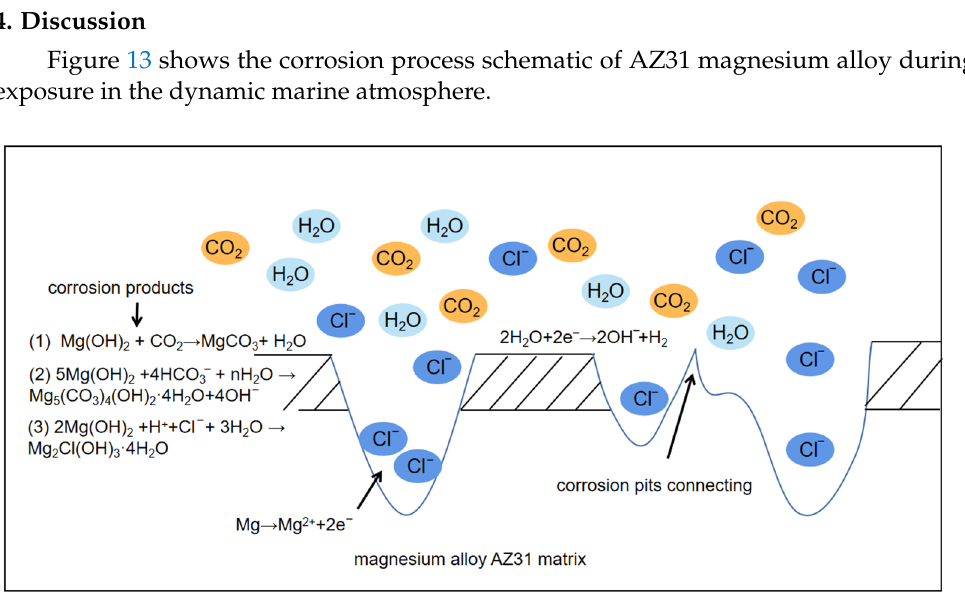
Figure 13. The corrosion process schematic of AZ31 magnesium alloy. During the initial stage of the reaction, chloride ions attached to the defects on the specimen surface and reacted with magnesium substrate and magnesium corrosion prod- ucts, and destroyed the integrity of the surface. The thin electrolyte layer of high